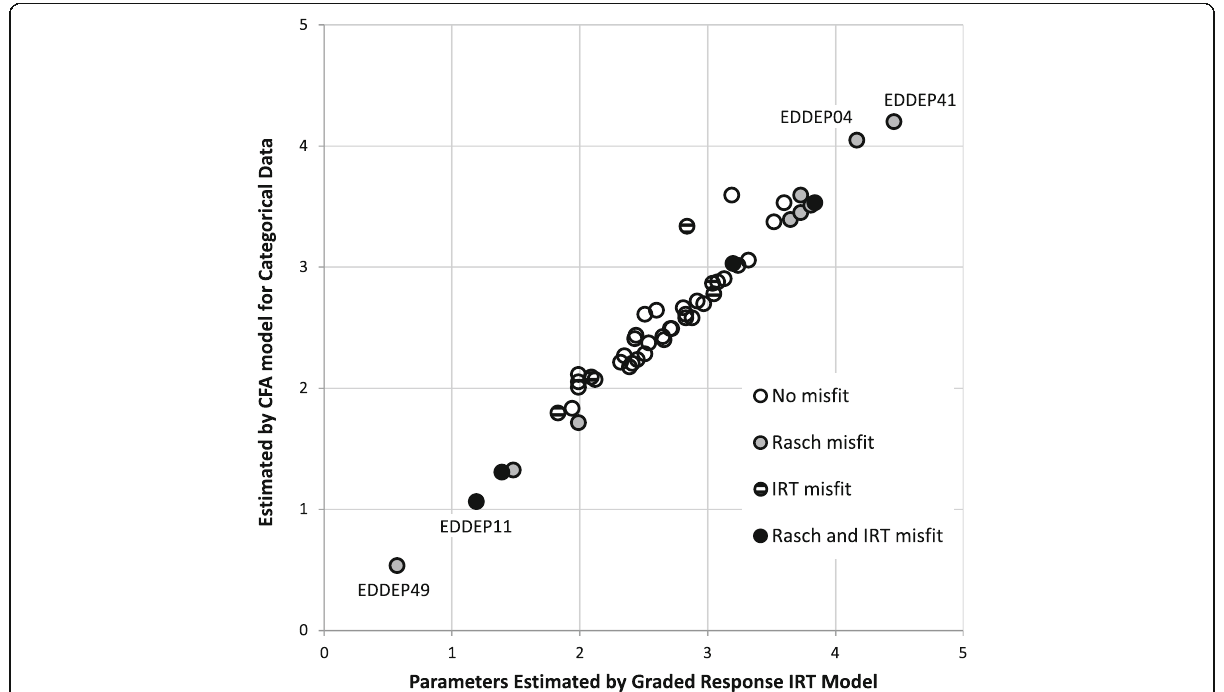
Fig. 2 Discrimination parameter estimates according to Confirmatory Factor Analyses (CFA) and Item Response Theory (IRT) models, and item